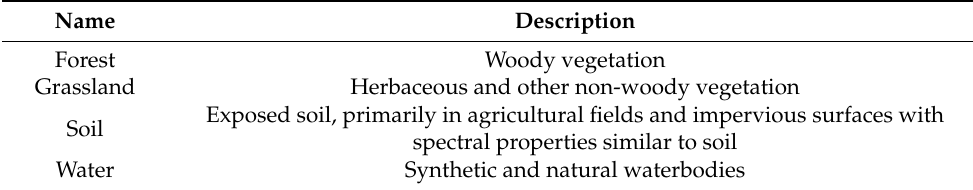
Table 1. Land-Cover